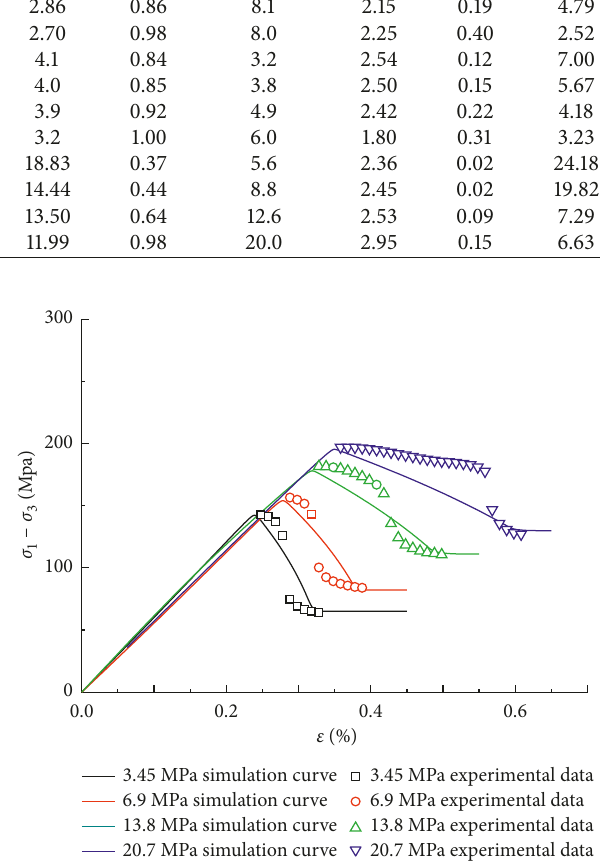
Figure 11: Comparison between Tennessee marble triaxial com- pression test data and numerical simulation